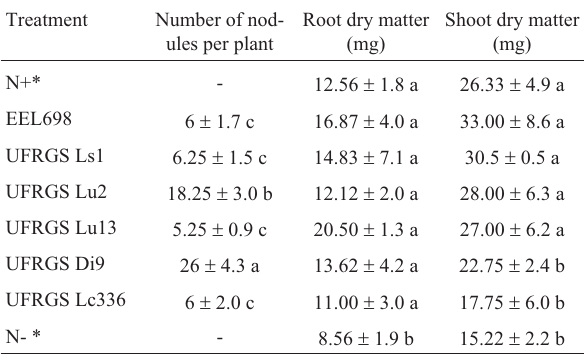
Table 3 - Greenhouse experiment with the inoculation of D. incanum plants and rhizobial isolates or reference strains that are able to nodulate both D. incanum and L. corniculatus